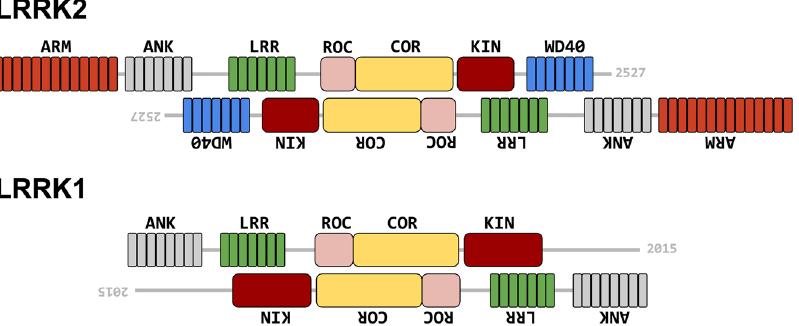
Figure 8. A model for the antiparallel arrangement of protomers in the LRRK2 and LRRK1 dimers. Depicted are the proposed overall orientations of the LRRK2 and LRRK1 dimers as derived from the models calculated from cryo-EM experiments, showing antiparallel orientation of LRRK2 and LRRK1 protomers in their respective dimers, as well as the extension of the N-terminal domain outside of the antiparallel